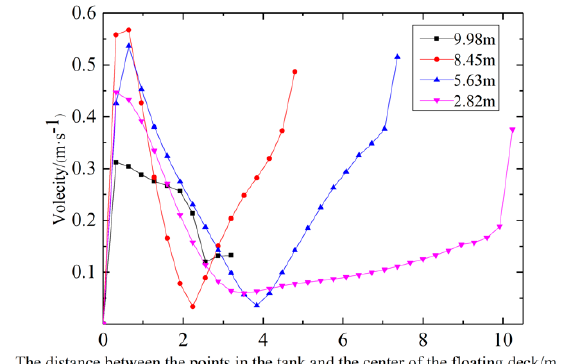
Figure 14. Location of monitored points.